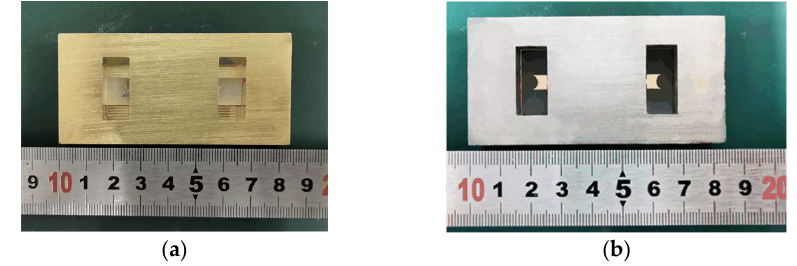
Figure 5. Photos of the fabricated prototype: ( a ) ( ε r = 10.2); ( b ) ( ε r = 2.22). The results show that the operation bandwidths of the two back-to-back transitions cover the entire X-band, meanwhile 44.7% ( ε r = 10.2) and 47.6% ( ε r = 2.22) of the broad- band are achieved with low loss and good impedance matching, respectively. As can be seen from Figure 6, the measurement and simulation results are in good agreement. The slight deviation is attributed to the fabrication tolerance and inaccuracy of assembly.